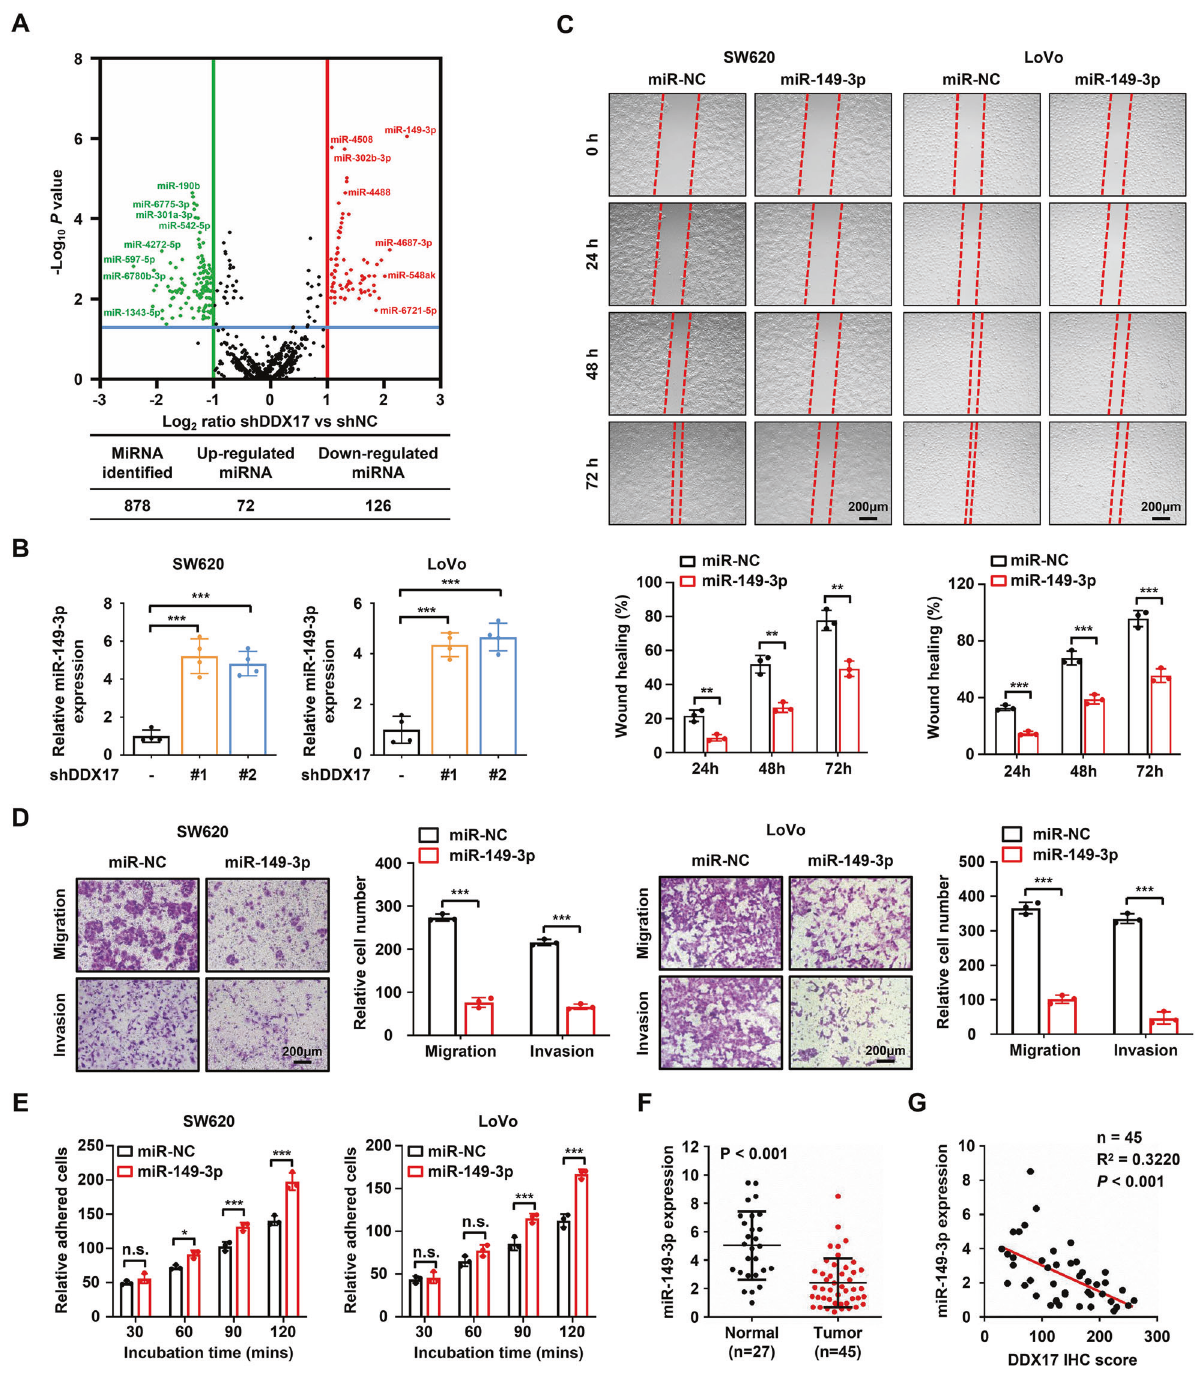
Fig. 4 MiR-149-3p inhibited the migratory and invasive abilities of CRC cells. A Volcano plot of dysregulated miRNAs in response to DDX17 knockdown. The twofold upregulated and downregulated miRNAs with adjusted p value < 0.05 are marked by red and green, respectively. B RT ‒ qPCR determined the impacts of DDX17 on miR-149-3p expression in SW620 and LoVo cells. C Microscopic observations were recorded at 0, 24, 48, and 72 h after scratching the surface of a con fl uent layer of the indicated SW620 and LoVo cells. D The effects of miR-149-3p on cell migration and invasion were examined by transwell assay in SW620 and LoVo cells. E The numbers of adhesive cells on the Matrigel were recorded after 30, 60, 90, and 120 min in the indicated SW620 and LoVo cells. F Relative miR-149-3p levels determined by RT ‒ qPCR analysis in 27 samples of normal mucosa tissues and 45 samples of CRC tissues. G Correlation analysis between DDX17 protein expressions and miR-149- 3p levels in CRC tissues. n.s. no signi fi cance, * P < 0.05, ** P < 0.01, *** P < 0.001. criterion of 1.5-fold change and adjusted p value < 0.05 (Supplemen- CYBRD1 is a direct target of miR-149-3p in CRC cells tary Tables S2, S3) as well as the predicted targets of miR-149-3p by To uncover the underlying mechanisms by which the DDX17/miR- the TargetScan database. Using this strategy, we identi fi ed 6 149-3p axis controls CRC metastasis, we carried out RNA sequencing potential miR-149-3p target genes that were regulated by DDX17 and analyzed the downregulated genes triggered by DDX17 with a